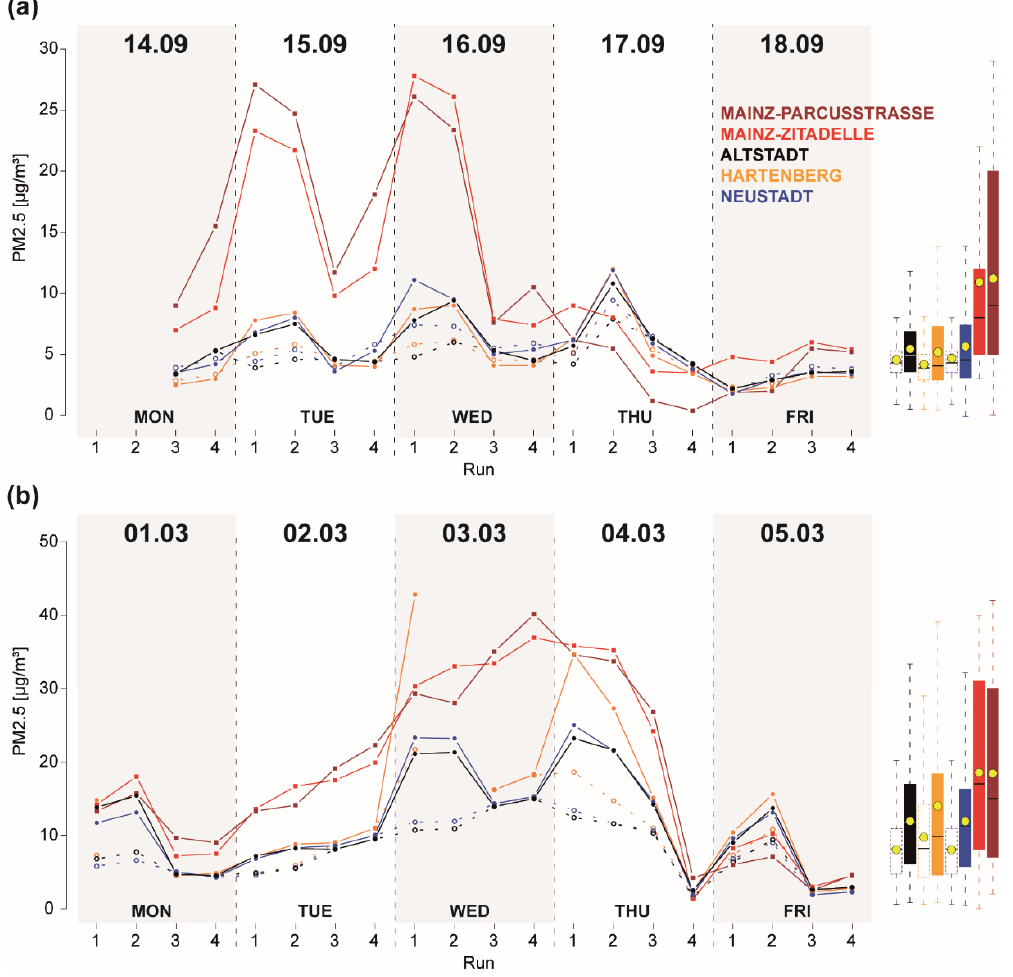
Figure 4. Mean PM 2.5 concentrations in the Altstadt, Hartenberg, Neustadt (black, blue, and orange colors, respectively), and ZIMEN data from the Mainz-Parcusstraße and Mainz-Zitadelle (dark red and red colors, respectively) during the study periods in ( a ) September and ( b ) March with corresponding boxplots and arithmetic means (yellow dots). The unfilled dots symbolize the humidity-corrected PM 2.5 measurements, and the filled dots symbolize PM 2.5 concentrations without humidity correction.